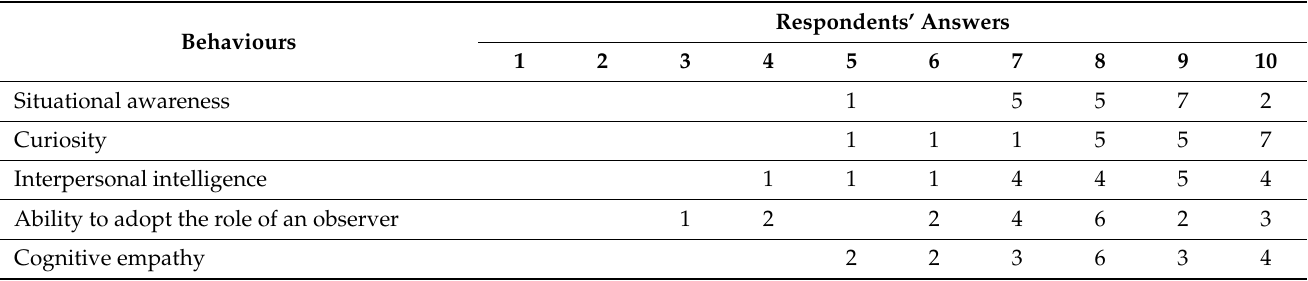
Table 3. Key behaviors and skills in the VUCA environment.